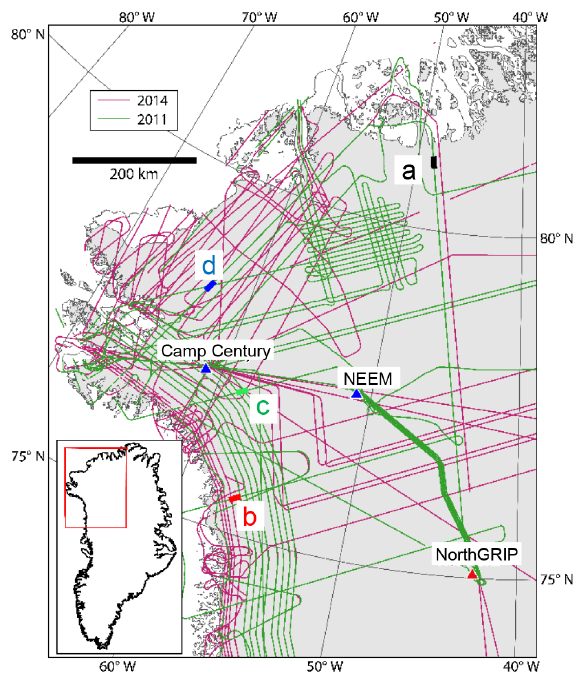
Figure 3. Data coverage map for OIB flight tracks and region of interest. The locations of the Camp Century, NEEM, and North- GRIP ice cores are indicated, along with the terrain profile sections in Fig.